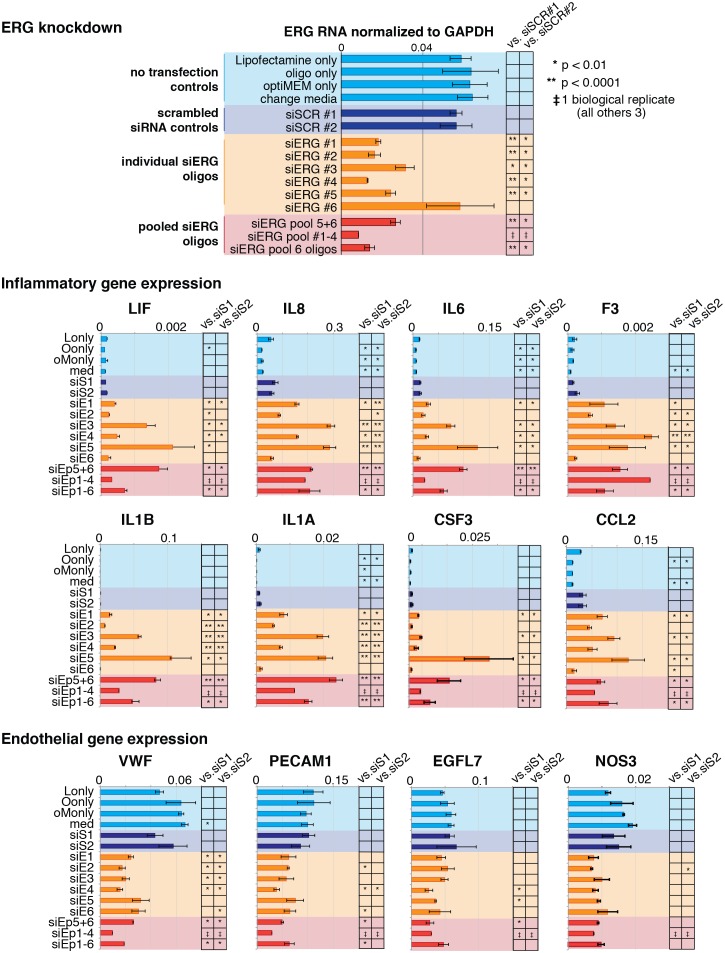
Changes in gene expression with ERG knockdown measured by RT qPCR.Gene expression measured by RT- qPCR in no transfection controls, with scrambled siRNA, individual siERG oligos, and pooled siERG oligos for genes that either inflammatory or endothelial-specific genes. List of primers and oligos used is in Supplementary file 3.